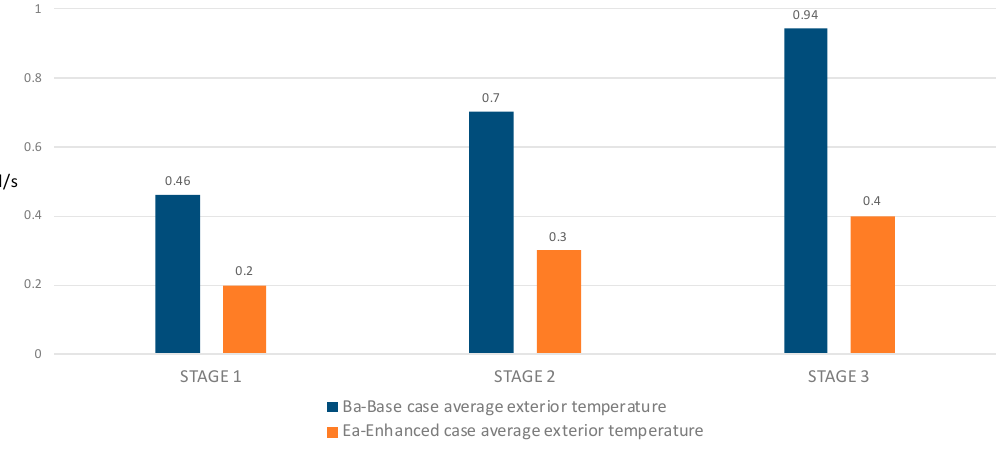
Figure 16. Modeled flow capacities—heating demand.